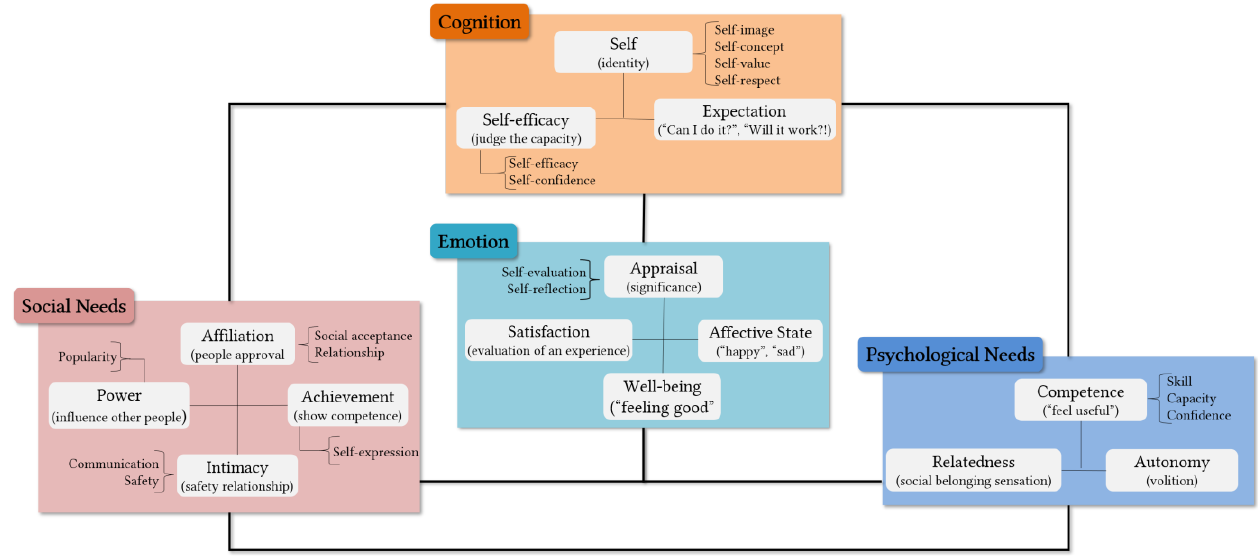
Figure 2 . Self-determination theory concepts and their relation to self-esteem